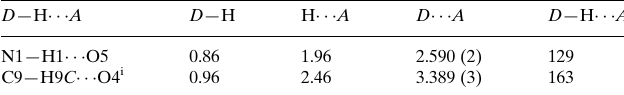
Hydrogen-bond geometry (A˚ , (cid:2)